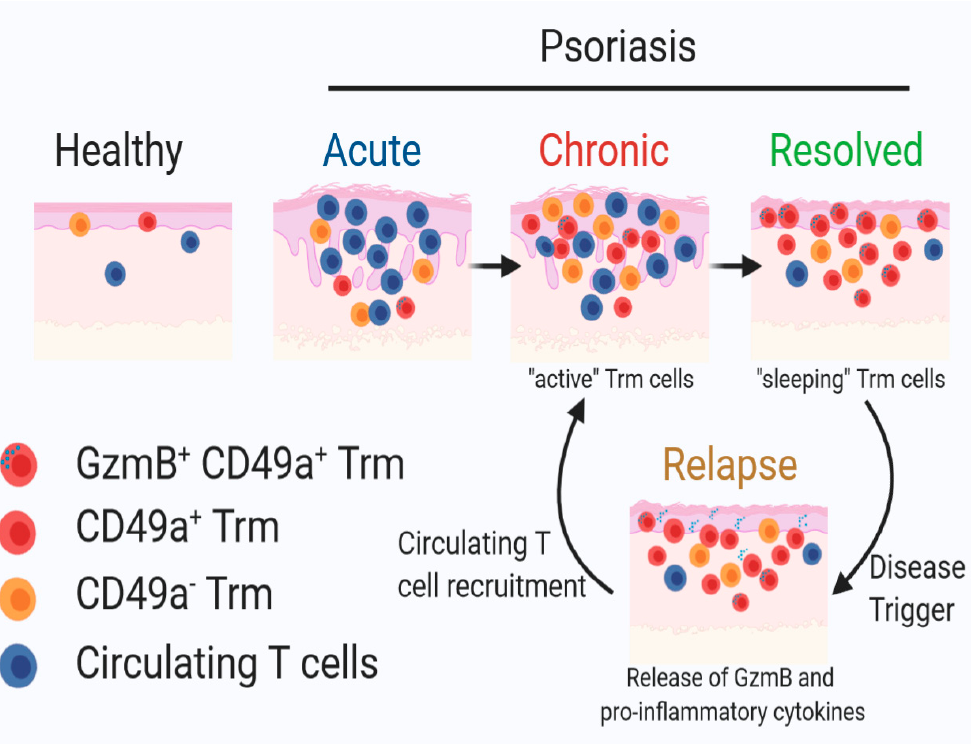
Figure 5 . A schematic diagram of our proposed mechanism illustrating the role of CD49a + Trm cells in clinical relapse underpinning psoriasis pathogenesis. Image was generated using BioRender.